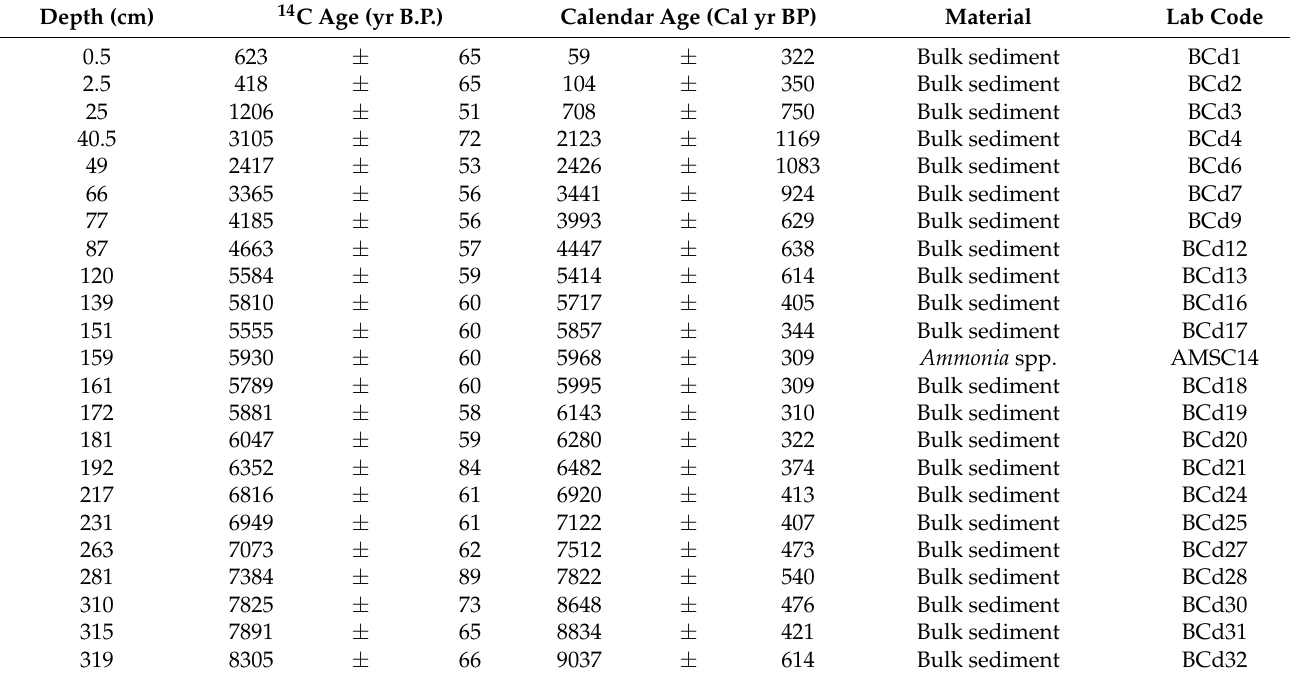
Table 1. The 14C data used to construct the Age